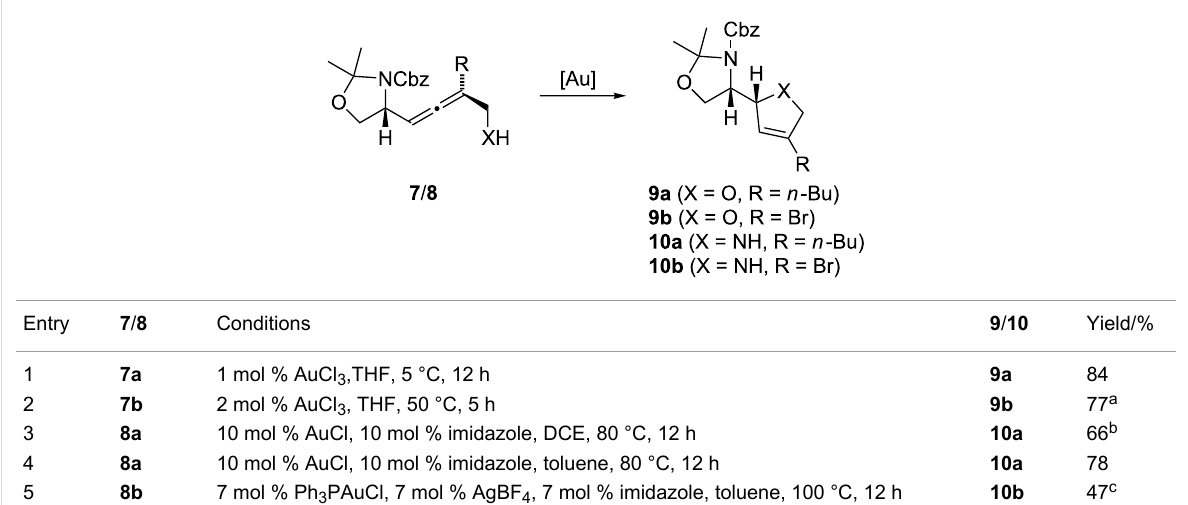
Table 2: Gold-catalyzed cycloisomerization of allenes 7 and 8